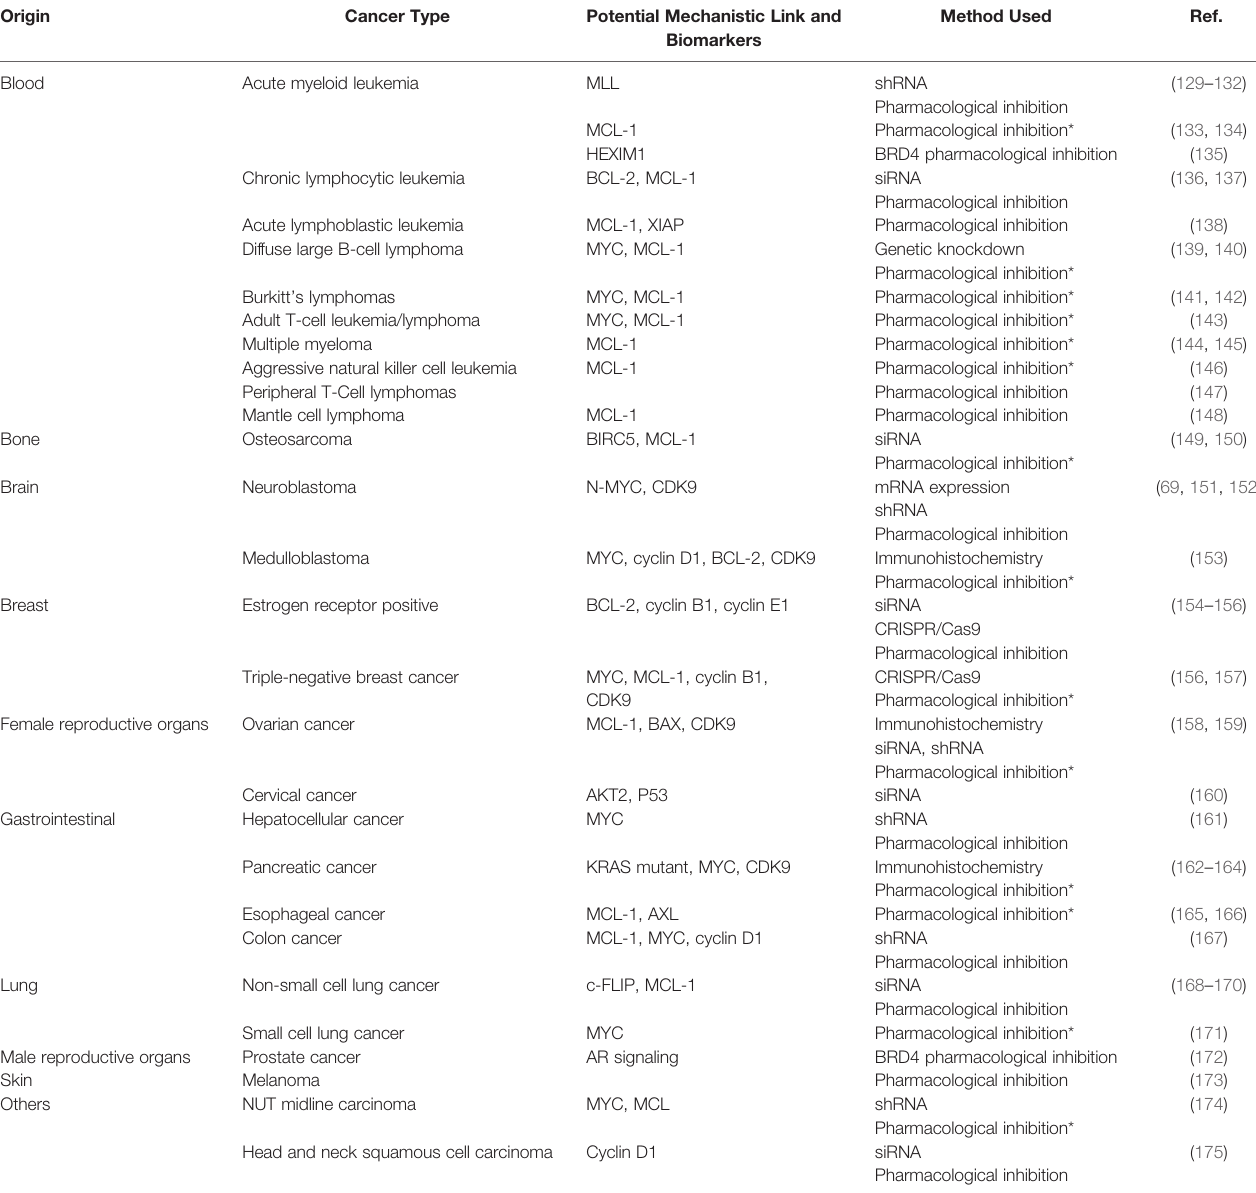
TABLE 1 | Studies that have described links between P-TEFb and different cancers.